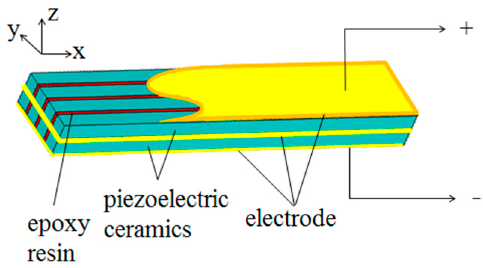
Figure 1. Structure of the piezoelectric composite bilaminated vibrator.